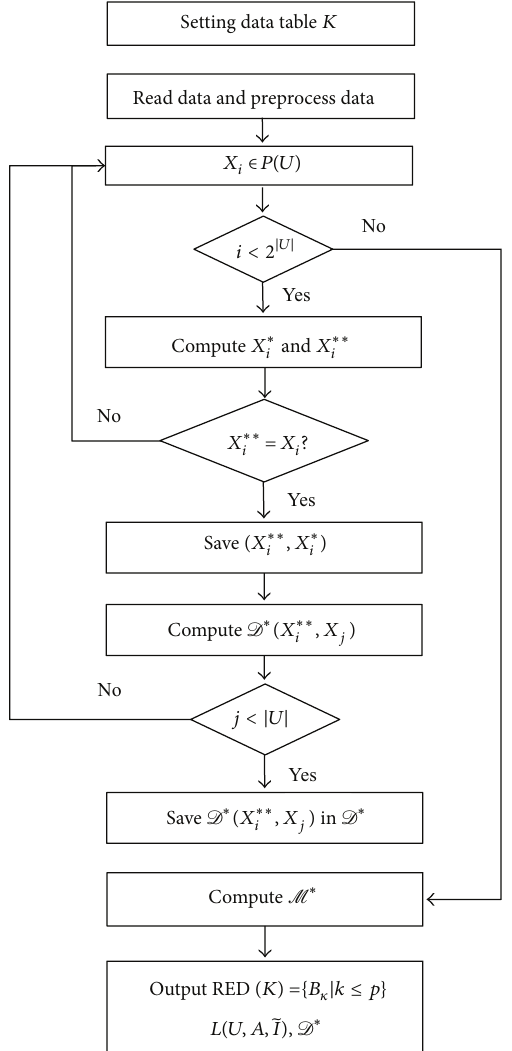
Figure 3: The flow chart of Algorithm 39.